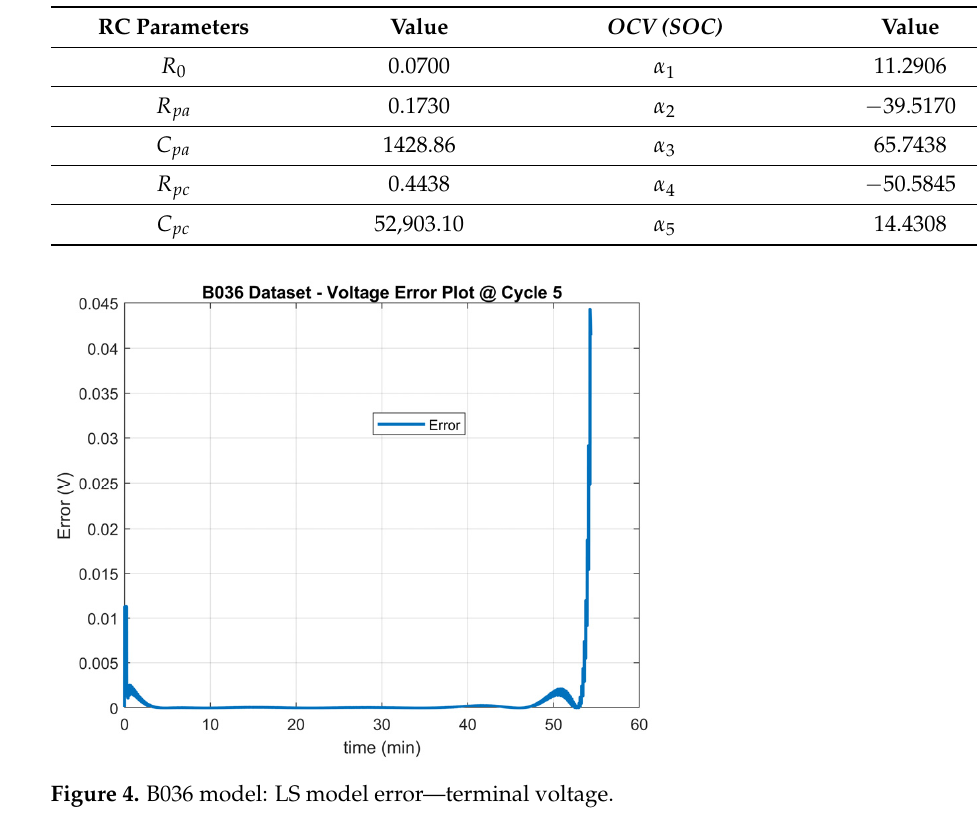
Table 2. NLLS Parameter Estimation Results.